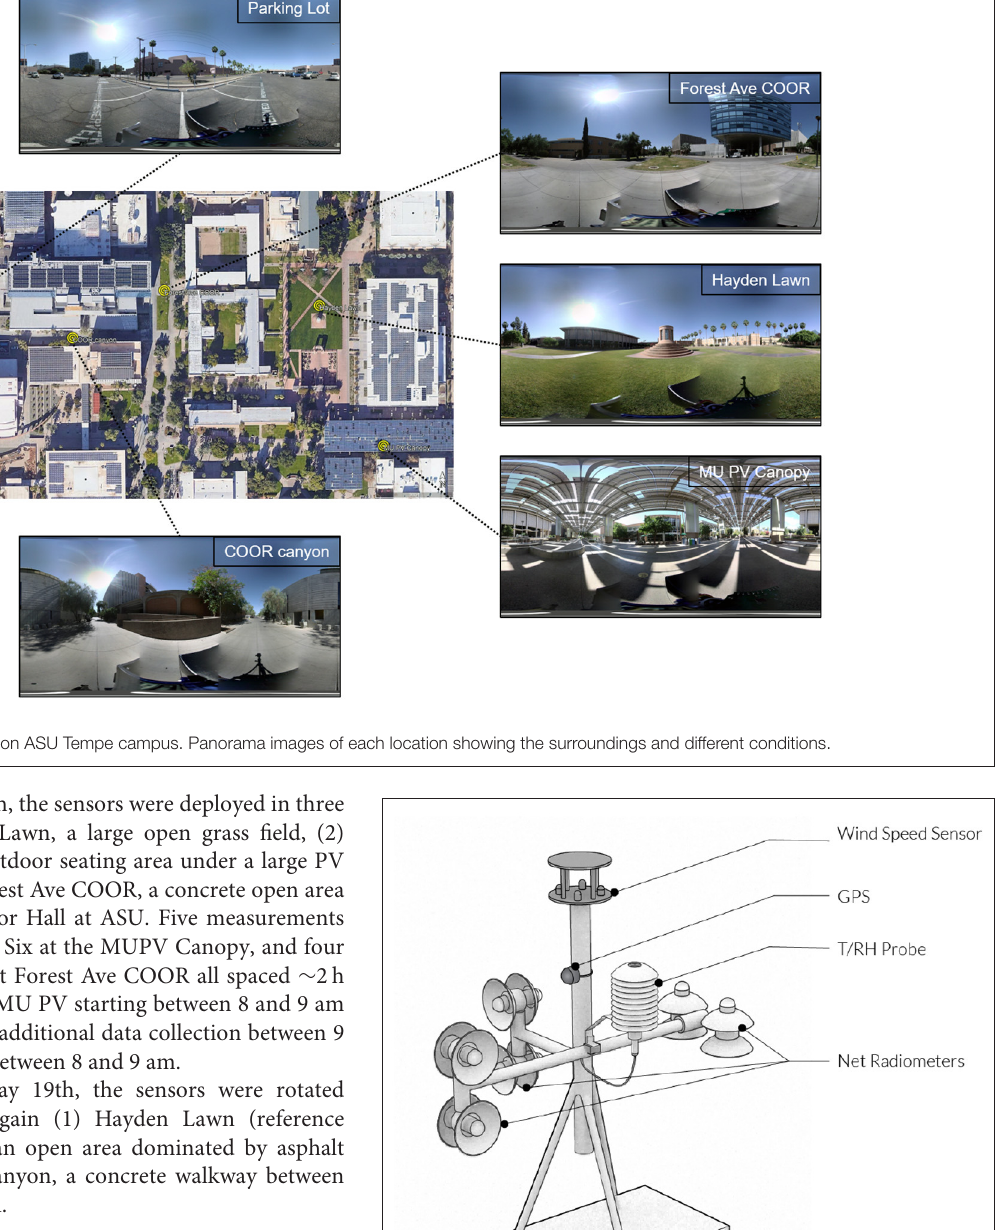
determines MRT from combining net radiometer readings of directional shortwave and longwave radiation, weighting each direction according to angular factors of a standing person as